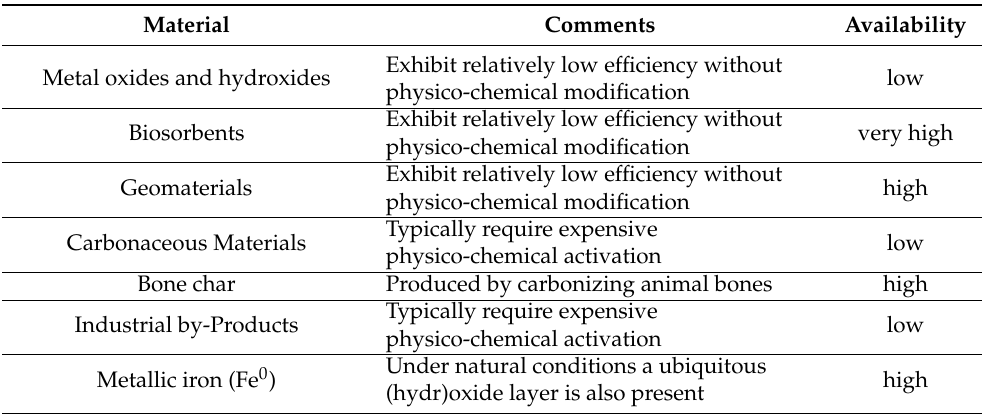
Table 1. Availability of common adsorbents for aqueous fluoride